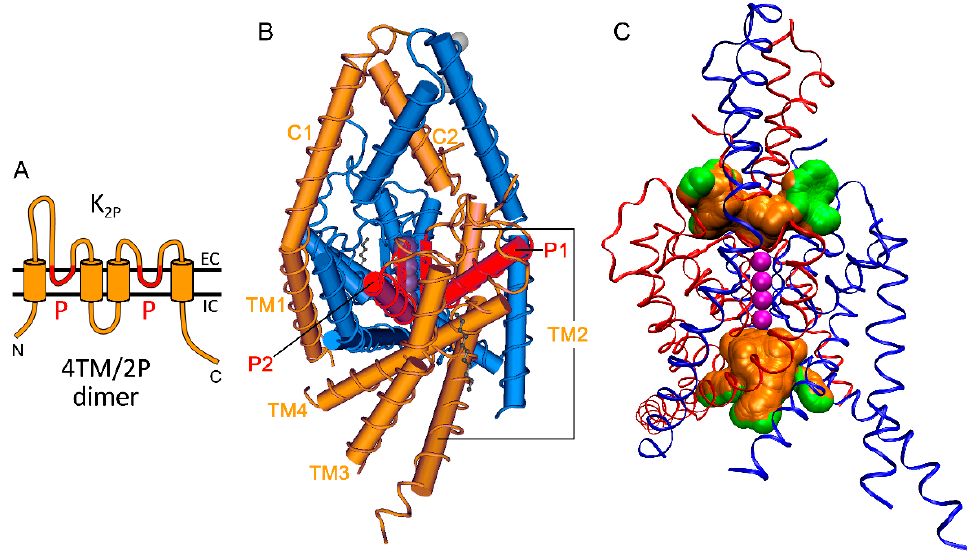
Figure 1. Schematic overview of the structure of K 2P background potassium channels. ( A ) The general transmembrane topology of K 2P channels is 4TM/2P. Only one subunit of the dimer is shown. The membrane is illustrated with two horizontal black lines, both the N- and C-terminus of the subunit (N and C) are intracellular (IC). The subunit contains two pore domains (P), which form reentrant loops on the extracellular (EC) side (indicated with red). A part of the long first extracellular loop, N-terminal to the first pore domain, constitutes the extracellular cap structure. ( B ) The panoramic view of the crystal structure of TREK-2 homodimer is shown from the extracellular side (PDB: 4BW5). One subunit is orange (pore loops are red) and the other is blue, and the α -helical regions are illustrated as tubes. The first transmembrane segment (TM1) is followed by the two cap helices (C1 and C2). After C2, the first pore helix (P1) diagonally immerses into the transmembrane space, and the chain vertically returns to the EC side as the (TVGYG-like) signature sequence of the selectivity filter (narrow rectangle close to the K + binding sites, illustrated with spheres). The pore helix and the signature sequence belong to the first pore domain, as illustrated in panel A. The amino acid chain continues as the (not entirely straight) TM2 and TM3 transmembrane helices, followed by the second pore domain, which includes the P2 pore helix and the other signature sequence rotated by approx. 90 degrees around the axis of the pore, compared to the first one. Finally, the chain returns to the IC side as the TM4 transmembrane helix. Some coils connecting the helical elements (e.g., between C2 and P1, TM2 and TM3) and the long C-terminal tail following TM4 are missing from the crystal structure. The figure was produced by the Cn3D software of NCBI. ( C ) The extracellular ion pathway (EIP) below the cap structure connects the EC end of the transmembrane pore to the EC space as a T-shaped bifurcation. The narrow selectivity filter region of the transmembrane pore is illustrated as a series of four K + binding sites (purple spheres). Below the selectivity filter, the pore widens as the central cavity. The TREK-2 homodimer is rotated by about a quarter turn, compared to panel B , the cap helices of the two subunits almost overlap in the illustration. The EIP and central cavity are determined as the spaces accessible by a small sphere (radius 2.1 Å), but not by a large one (radius 4.5 Å for the EIP and 8.1 Å for the central cavity), by using PrinCCes [10] and VMD [11] software. The green spheres are adjacent to bulk fluid.